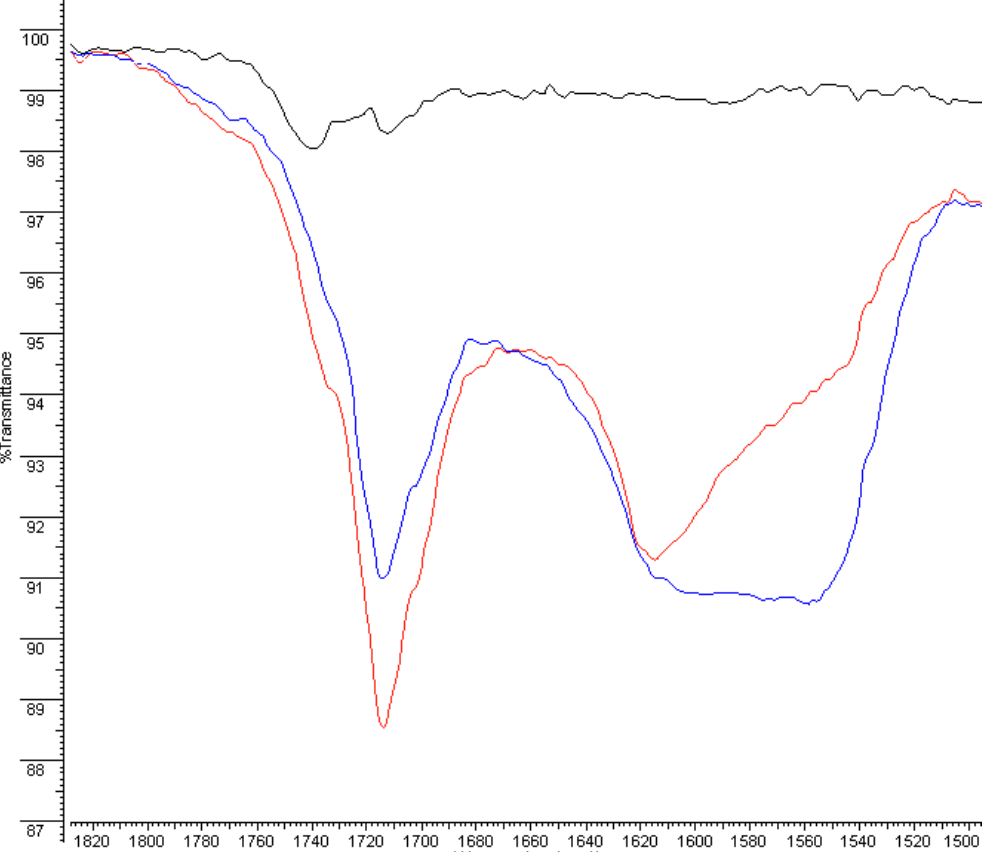
Figure 4 . FT-IR spectra of PERT inner surface: new (black), 4 weeks (red), and 8 weeks (blue) .